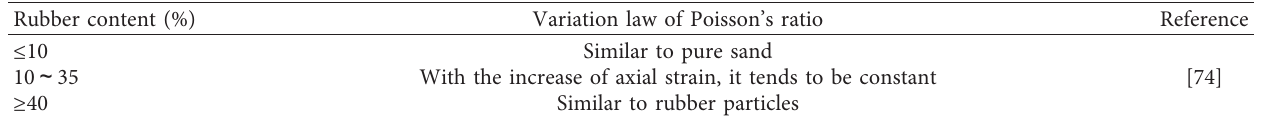
Table 5: Change rule of Poisson’s ratio of rubber sand.